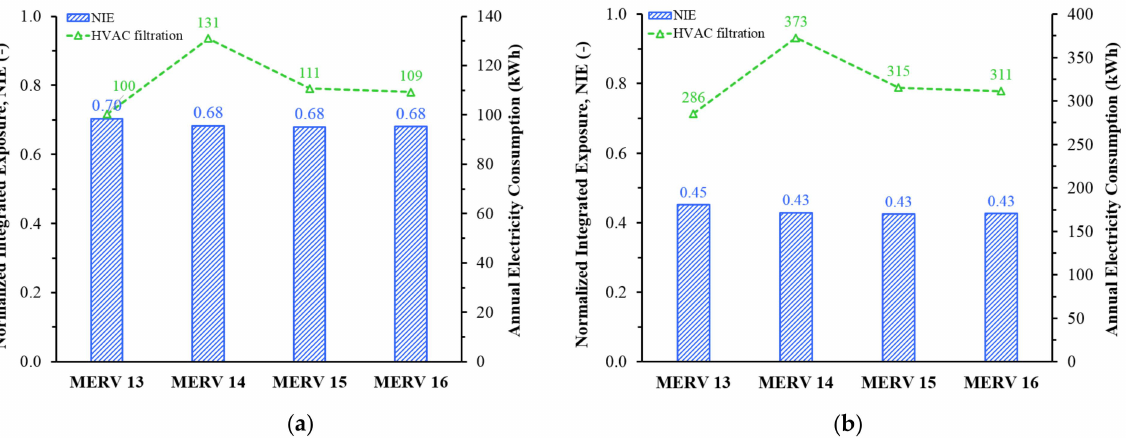
Figure 8. Effect of recirculated air filtration using HVAC filters on the NIE and its associated additional electricity consumption for 3 h per day of continuous exposure: ( a ) CAHS, ( b )